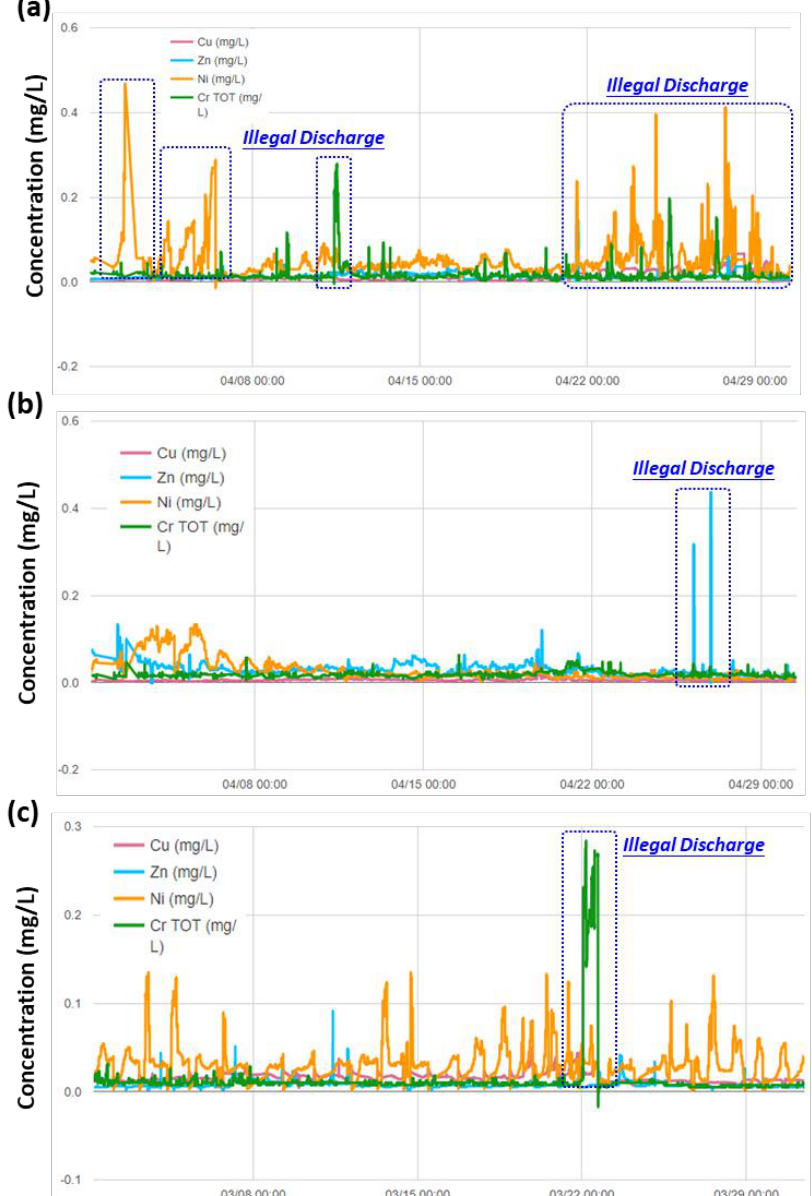
Figure 8. Patterns and trends of heavy metals monitoring ( a ) at Taichung Zhanyiyuan ditch on April 2019, ( b ) at Changhua Xin ditch on April 2019, and ( c ) at Kaohsiung Hankou ditch on April 2019.